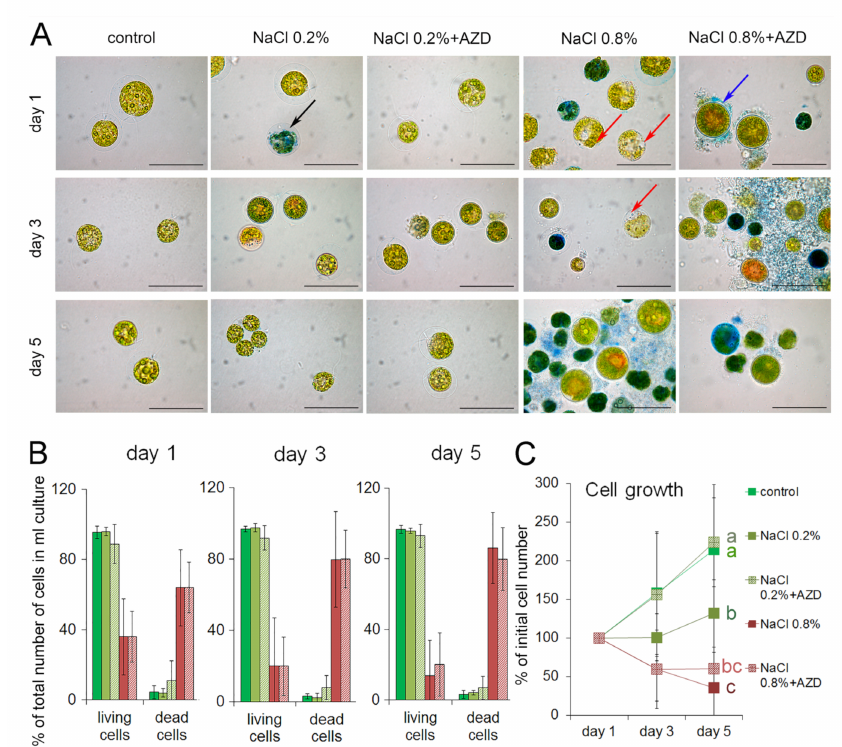
Figure 1. Growth of Haematococcus lacustris over five days in cultures containing 0.2% or 0.8% ( w / v ) NaCl, respectively, with or without addition of 0.2 µ M AZD8055 (AZD). ( A ) Images of representative cells taken from the cultures at day 1, 3, or 5 of treatment as indicated and stained with Evans’ Blue to visualize dead cells. Black arrow points at a representative blue-stained cell considered ‘dead’. Red arrows point at extremely vacuolated cells. A blue arrow points at an intermediate cell. Bars denote 50 µ m. ( B ) Changes in the proportions of living and dead cells as determined per unit of culture volume (mL); mean values from four independent experiments ± SD at day 1, 3, or 5 of treatment are shown. For the legend see C. ( C ) Growth dynamics at day 1, 3, or 5 of treatment; the cell density at day one was set to 100% for all cultures. Mean values from five independent experiments ± SD are given; different letters indicate significant differences between variants at the level of p < 0.05 according to one-way ANOVA and post hoc Tukey